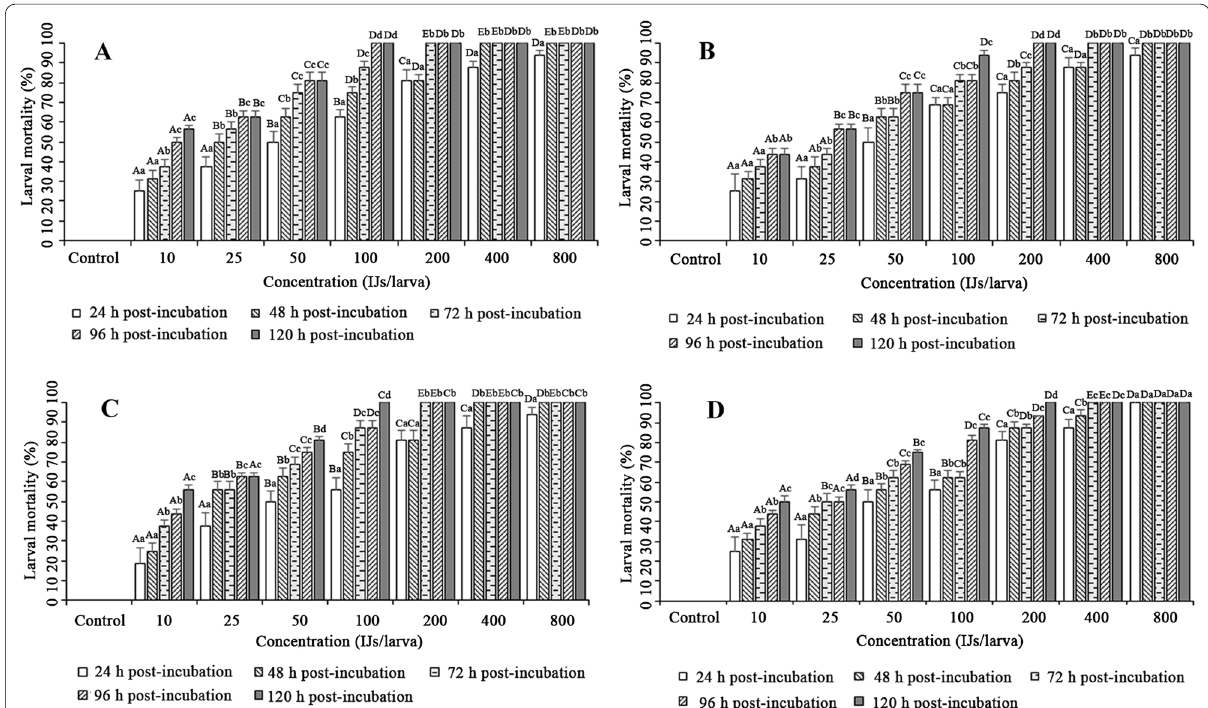
Fig. 2 Percentage mortality of 3rd instar Spodoptera frugiperda larvae upon exposure to different concentrations of A Heterorhabditis indica , B H. baujardi , C Steinernema sangi and D S.